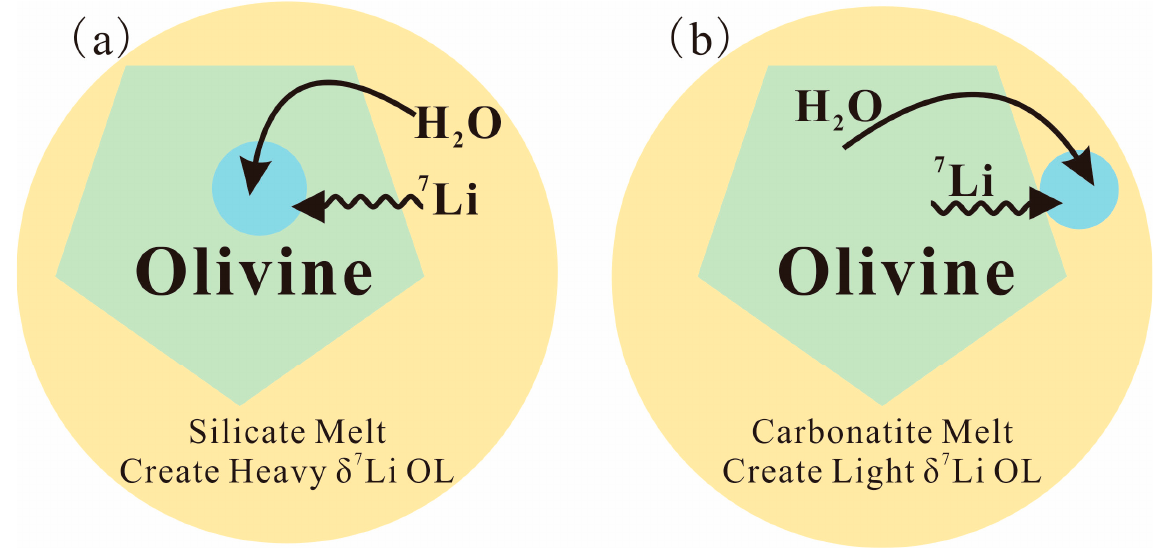
Figure 5. Model illustrating the behavior of water and its effects on Li isotopes during silicate ( a ) and carbonatite ( b ) metasomatism.